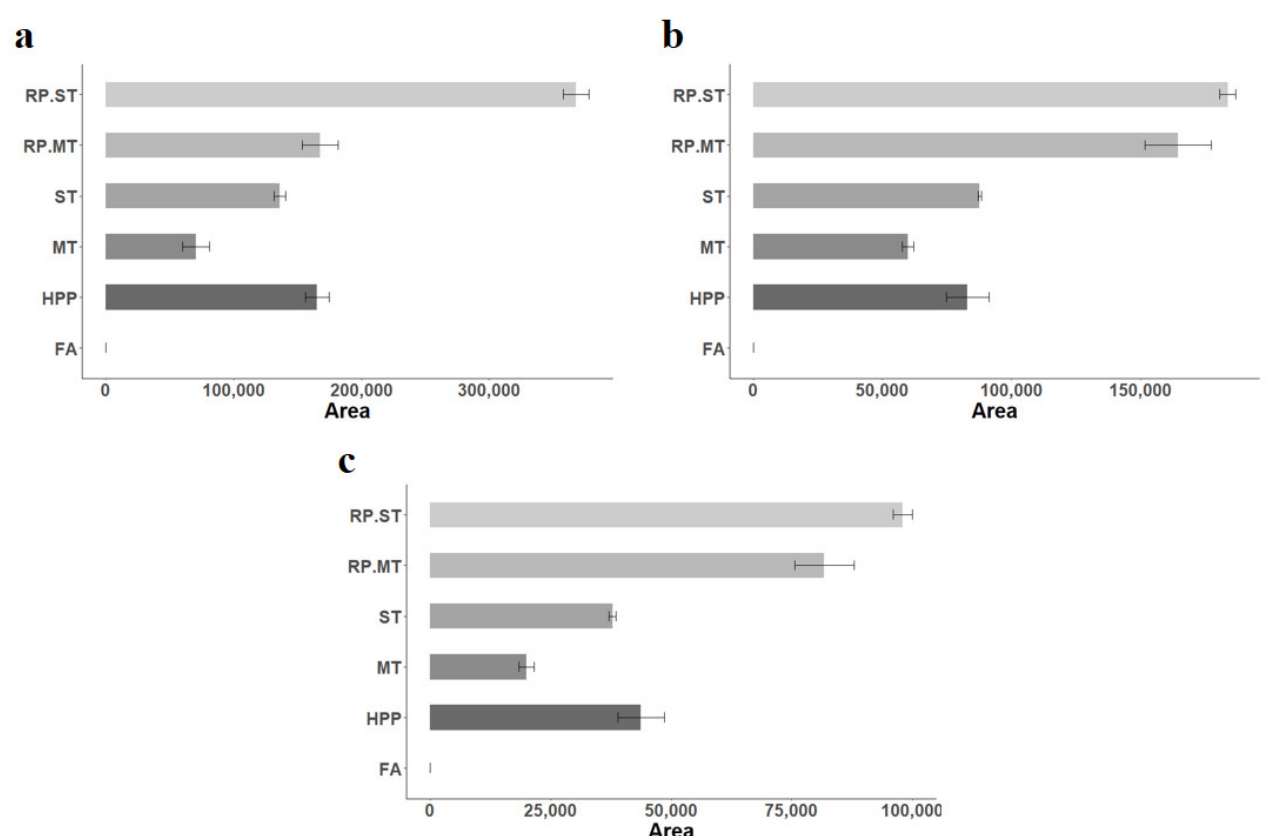
Figure 3. Bar plot of the metabolites identified in apple puree across the processing sample groups. X-axis: total abundance of the metabolite; Y-axis: treatment; ( a ) hydroxycinnamic acid glucuronide; ( b ) Caffeic acid; ( c ) LysoPE(18:3(9Z,12Z,15Z)/0:0). Apple samples: Fresh apple (FA), High-pressure processing (HPP), mild heat treatment (MT), standard thermal treatment (ST), reprocessed mild heat treatment (RP.MT), reprocessed standard thermal treatment (RP.ST).